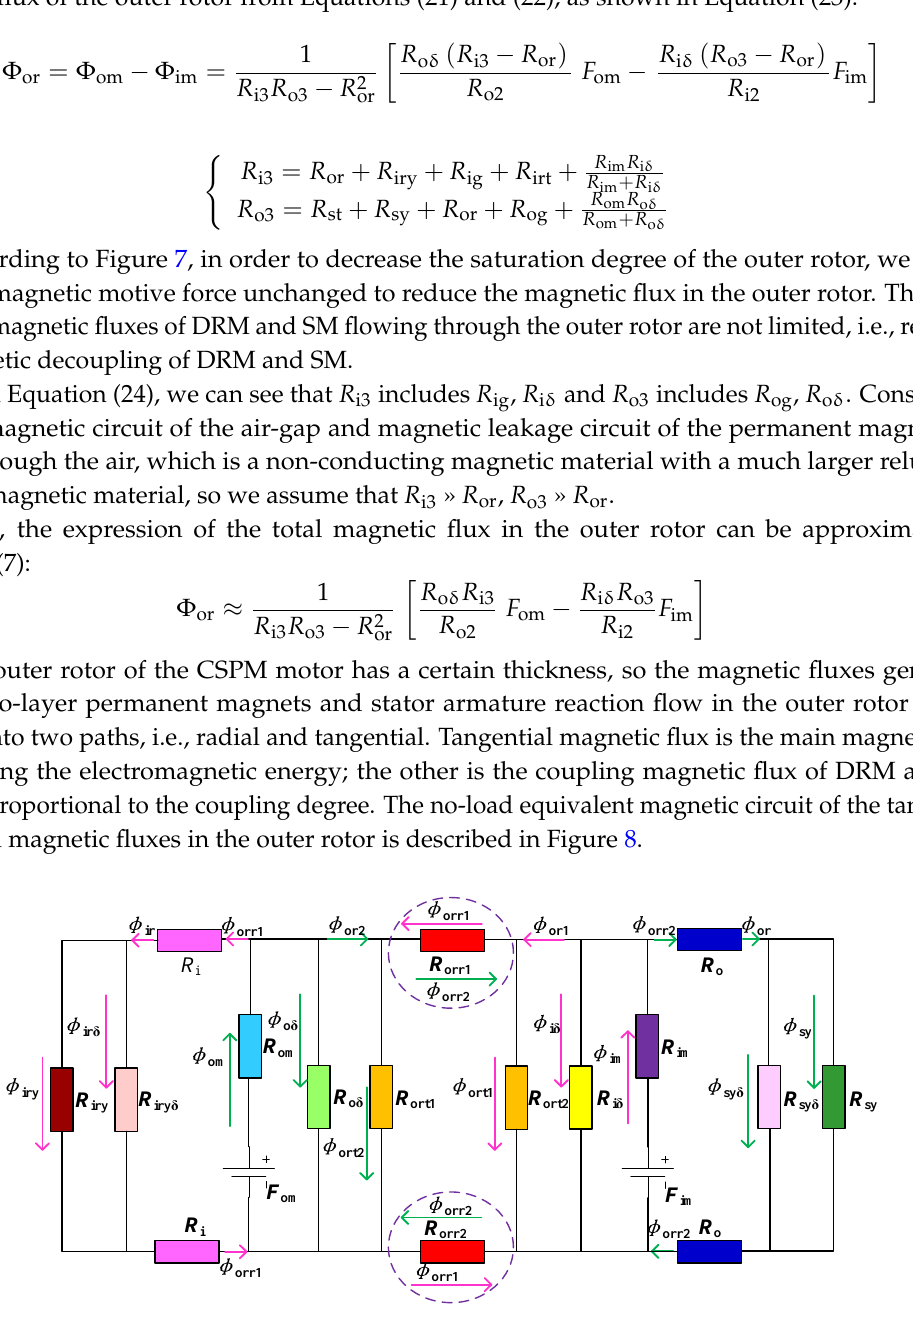
Figure 8. No-load equivalent magnetic circuit of the tangential and radial magnetic fluxes in the outer rotor. R orr1 , R orr2 are the equivalent radial reluctances of the outer rotor under the magnetic fluxes of DRM and SM; R ort1 , R ort2 are the equivalent tangential reluctances of the outer rotor under the